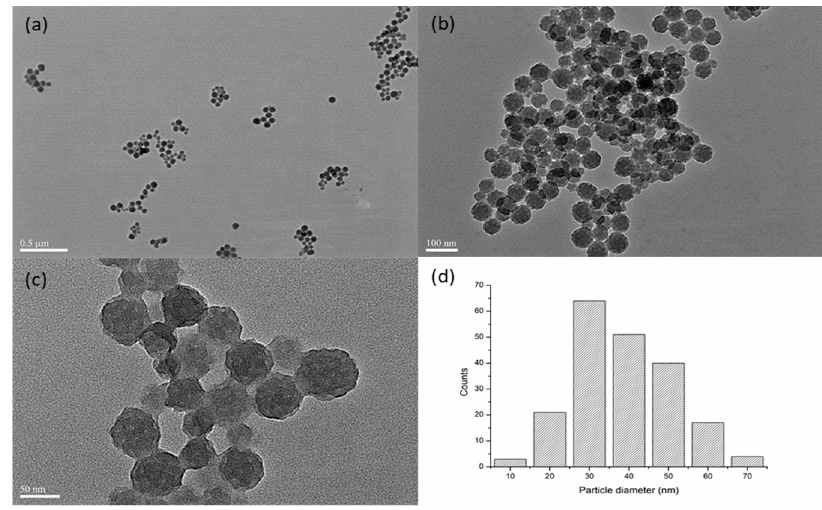
Figure 2 . TEM images ( a – c ) and size distribution ( d ) of silver nanoparticles.